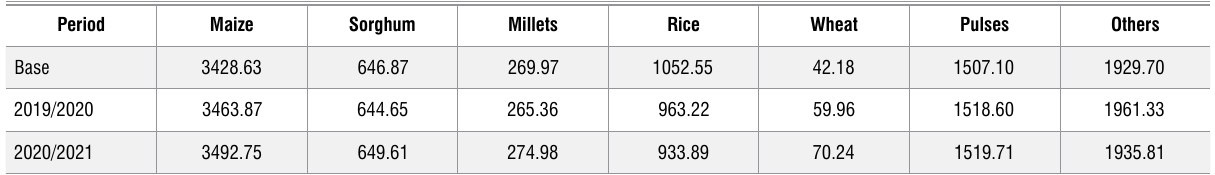
Projected area of major food crops of Tanzania (000’ ha) Period Maize Sorghum Millets Rice